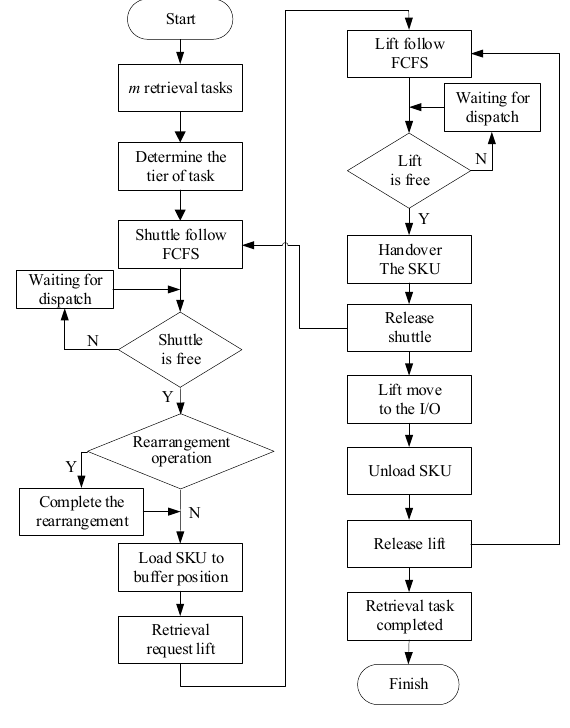
Figure 3. Flow chart for multi-tasking.